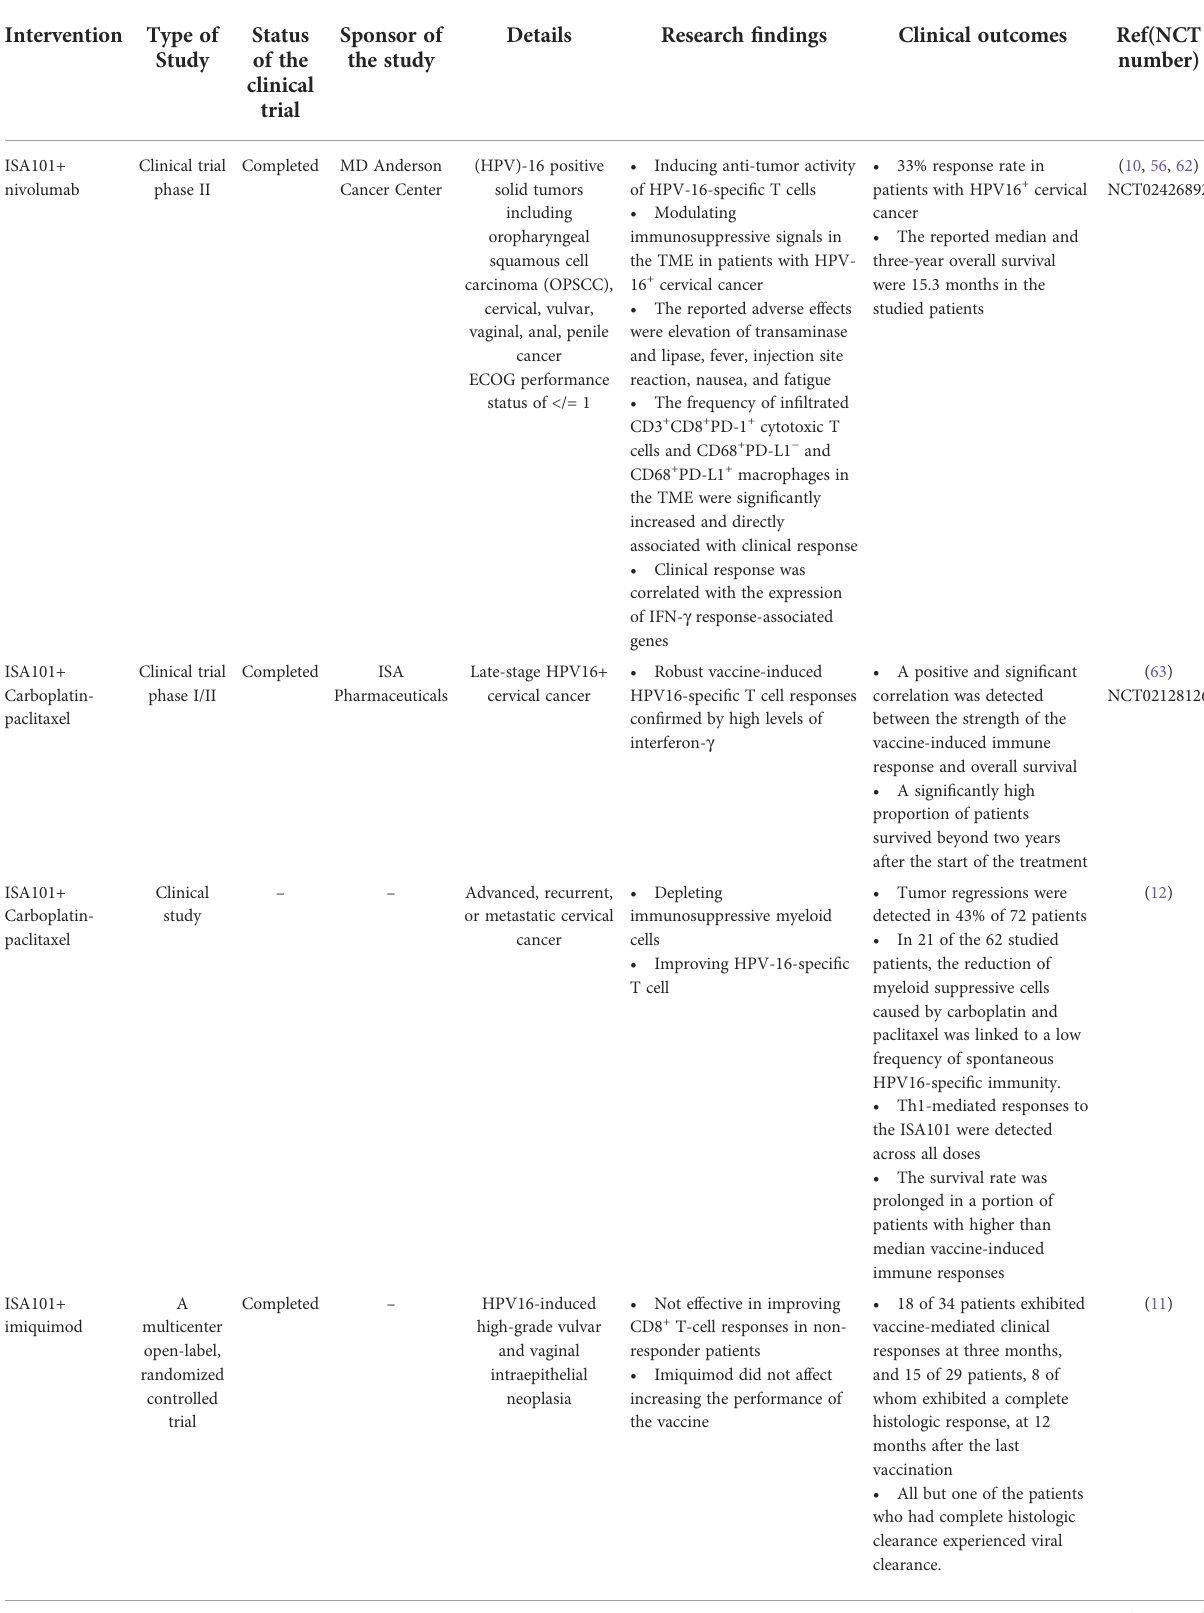
TABLE 3 Combination therapies using ISA101 in HPV-induced cervical